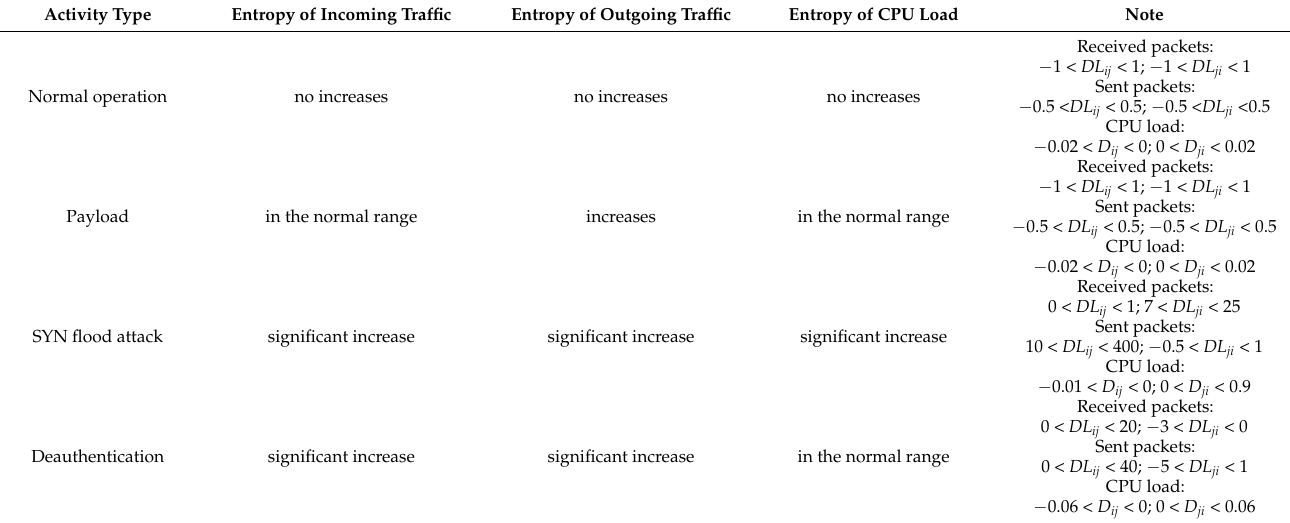
Table 2. Analysis of the ability to classify attacks by our anomaly detection